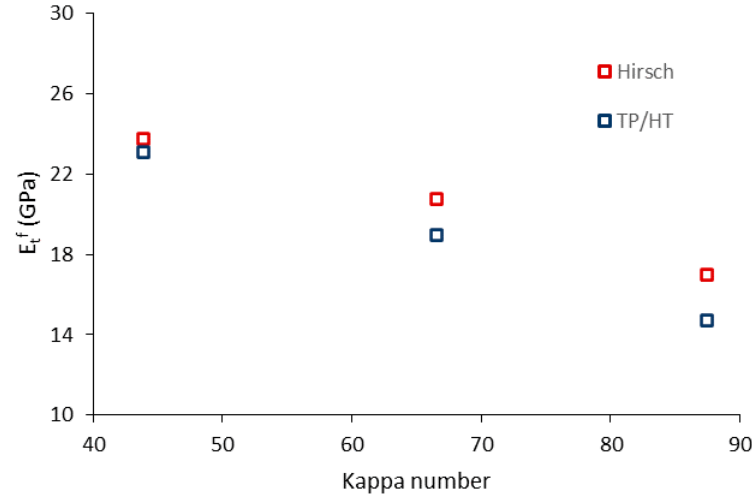
Figure 9. Evolution of the intrinsic Young’s modulus of the fibers with the kappa number.